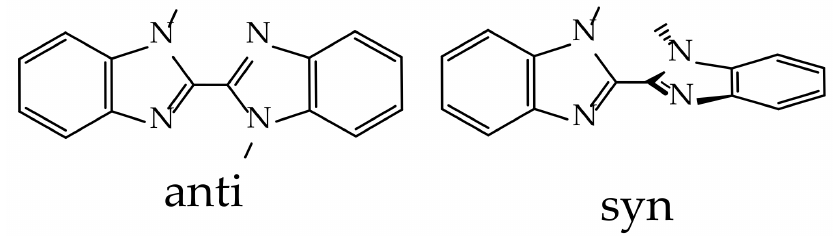
Scheme 2. Schematic representation of anti- and syn -geometries of